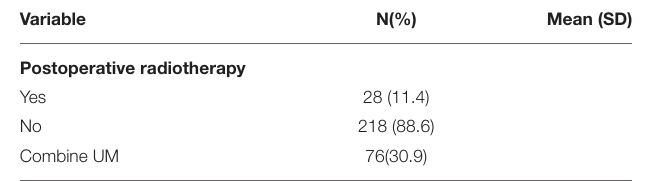
TABLE 1 | Baseline characteristics of the 246